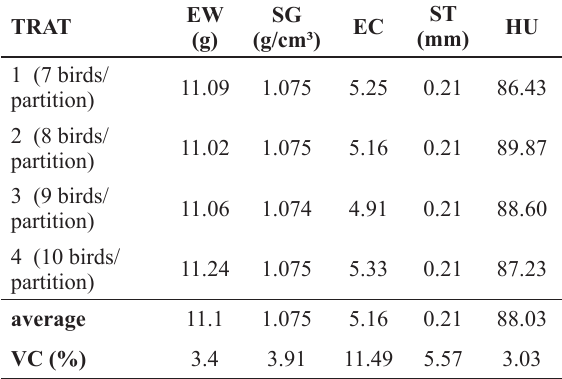
Averages followed by lower case letters in the same column do not differ statistically (Tukey, 5%). VC% means variation coefficient. Density effects on eggs weight (EW), laying (L) and mortality (MORT).